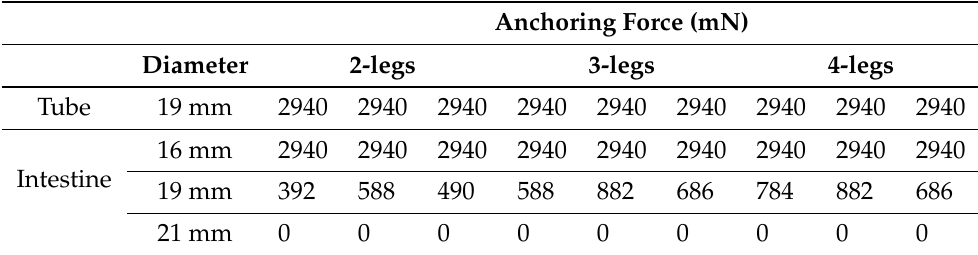
Table 1. Anchoring force measurement inside vinyl tube and